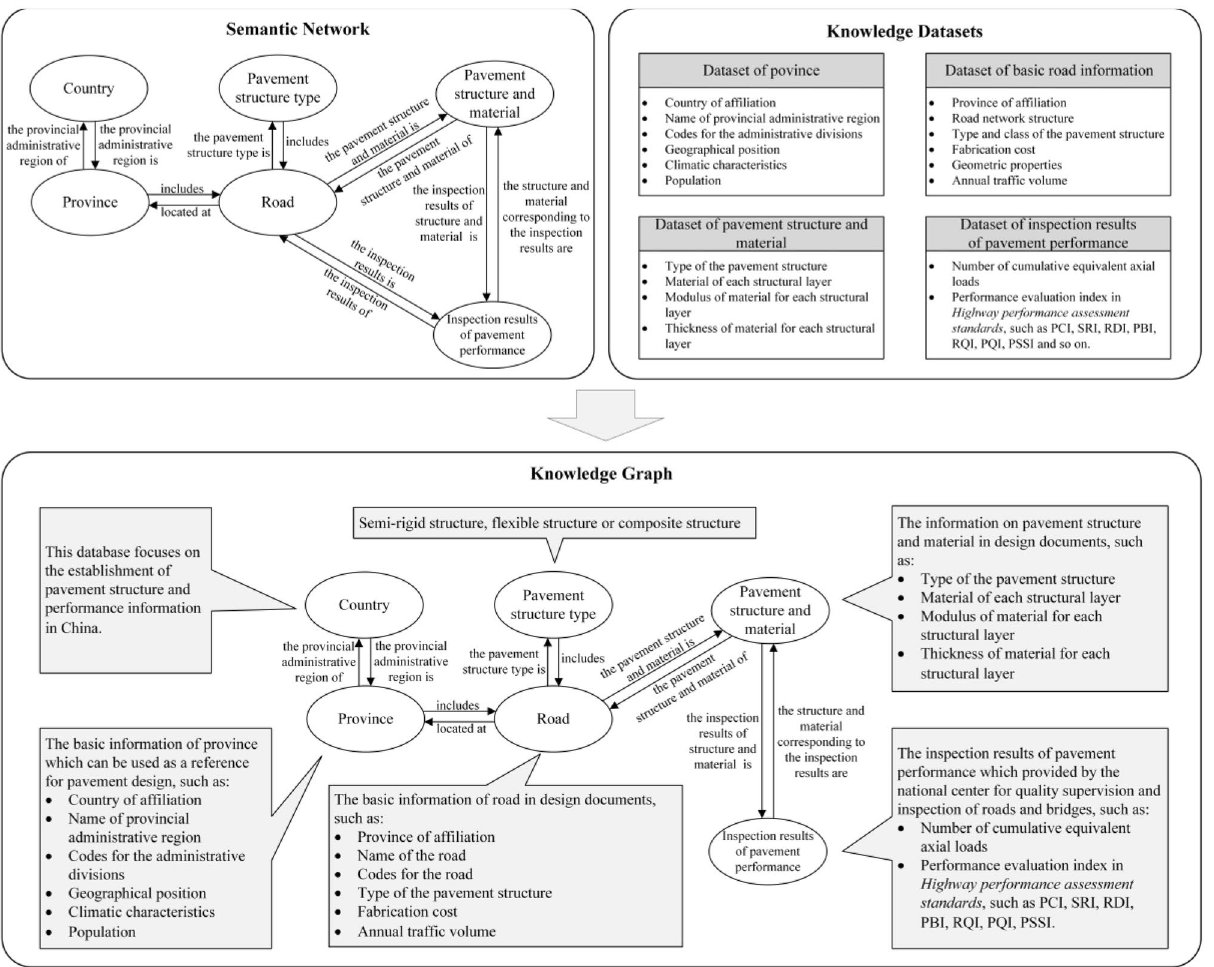
Figure 4. Construction of knowledge graph for pavement